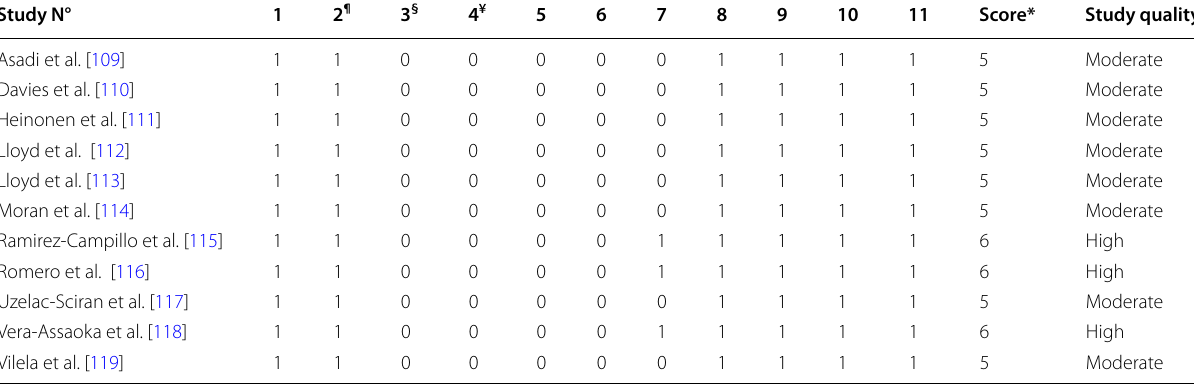
Table 2 Methodological quality of the included studies using the PEDro rating